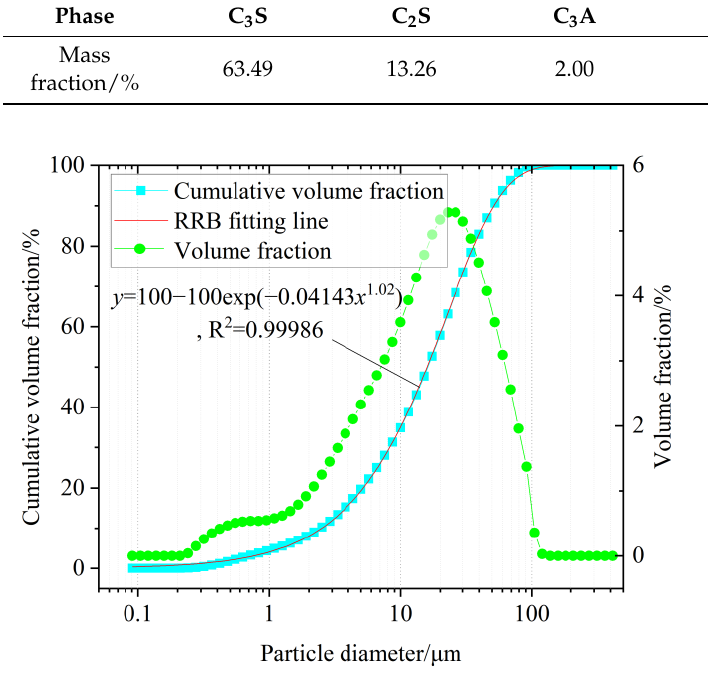
Figure 2. Particle size distribution of